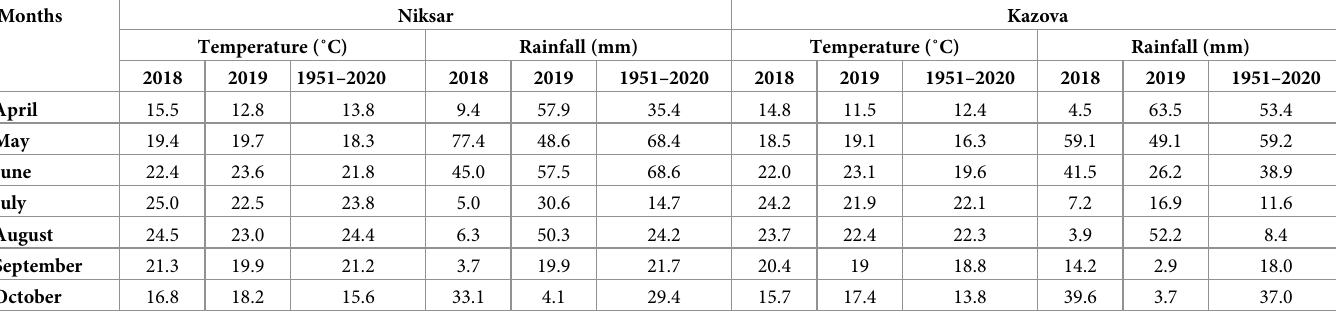
Table 2. Average temperature (˚C) and rainfall (mm) at Niksar and Kazova locations during the experimental years and between 1951 and 2020. Months Niksar Kazova Temperature (˚C) Rainfall